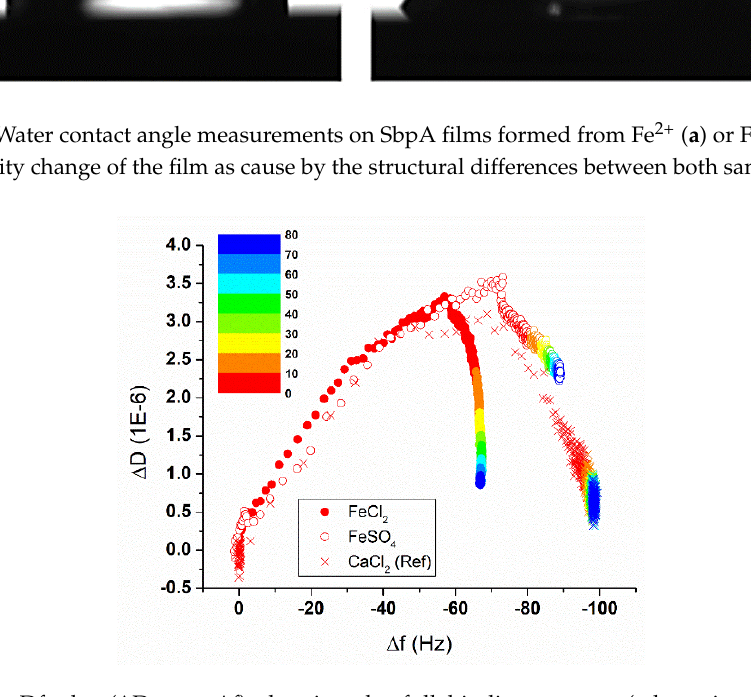
Figure A3. Df plot (∆D vs ∆f) showing the full binding process (adsorption + structural re-arrangement) of SbpA onto octanethiol-coated gold chips in the presence of different salts: Calcium chloride (crosses), Iron (II) sulfate (open circles), and Iron (II) chloride (filled circles). The color scale indicates the time elapsed after protein injection (in 10 min color steps).